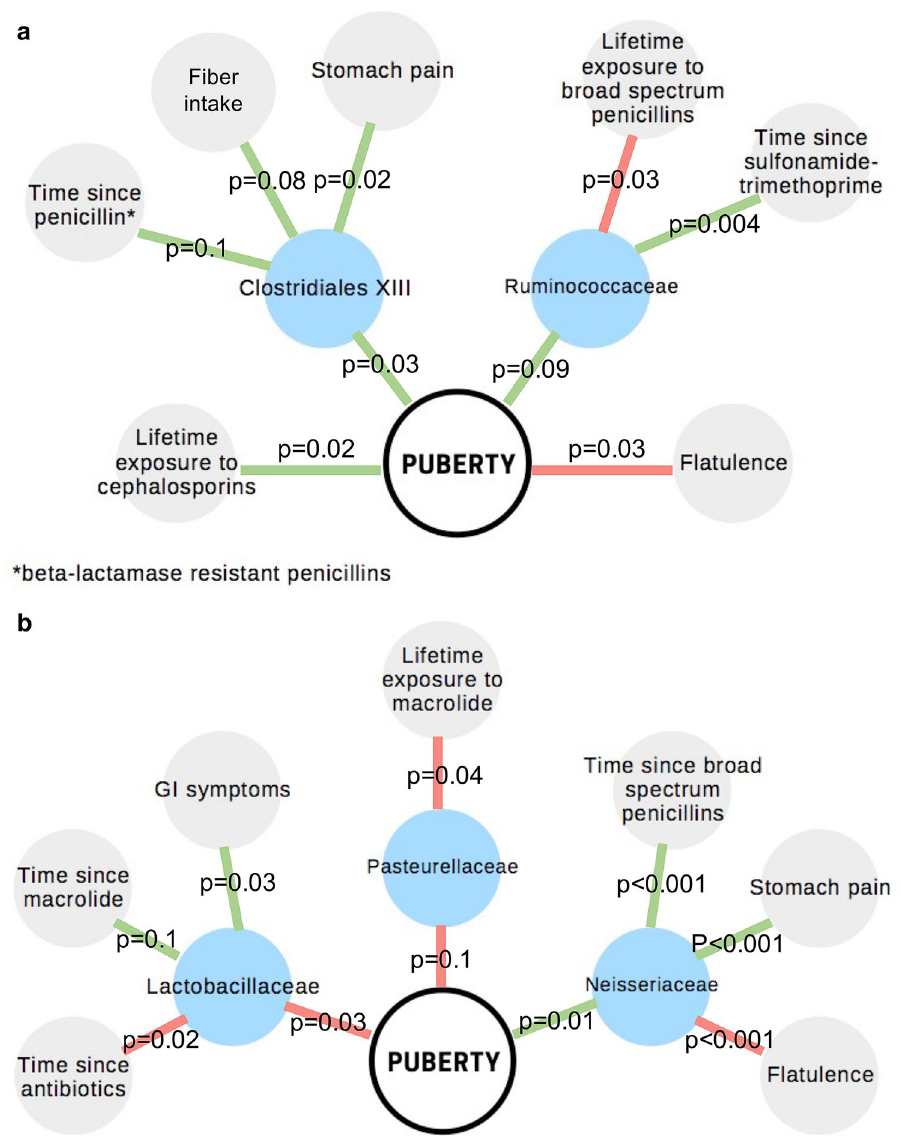
Figure 5. ( a ) Multivariate model for pubertal timing in girls. ( b ) Multivariate model for pubertal timing in